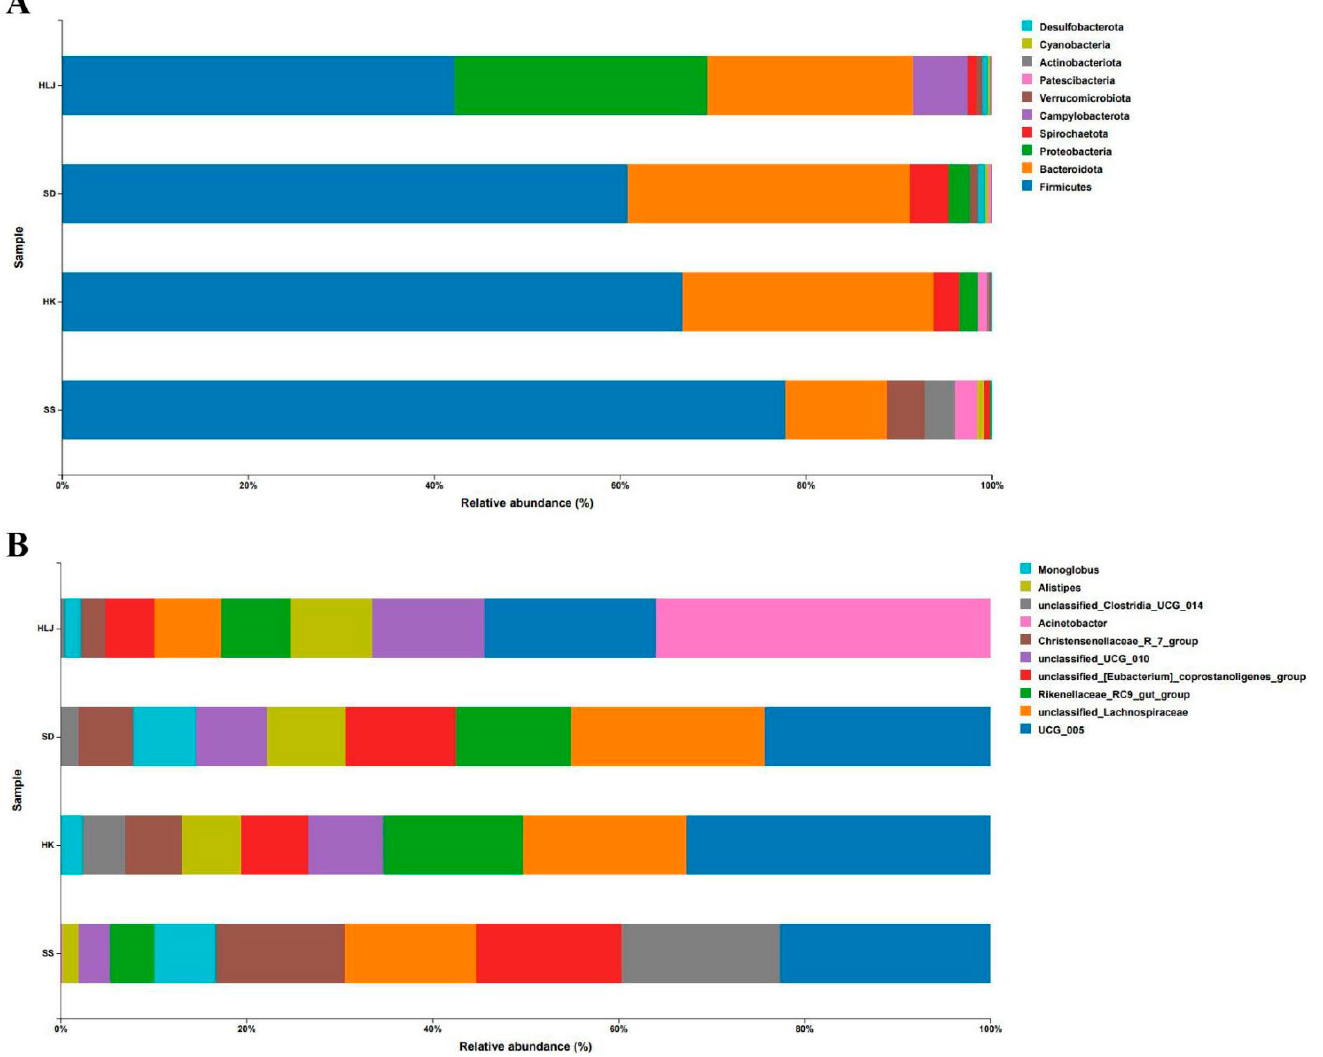
Figure 1. Histogram of the top 10 microbiota in each sampling location at the levels of phylum ( A ) and genus ( B ).